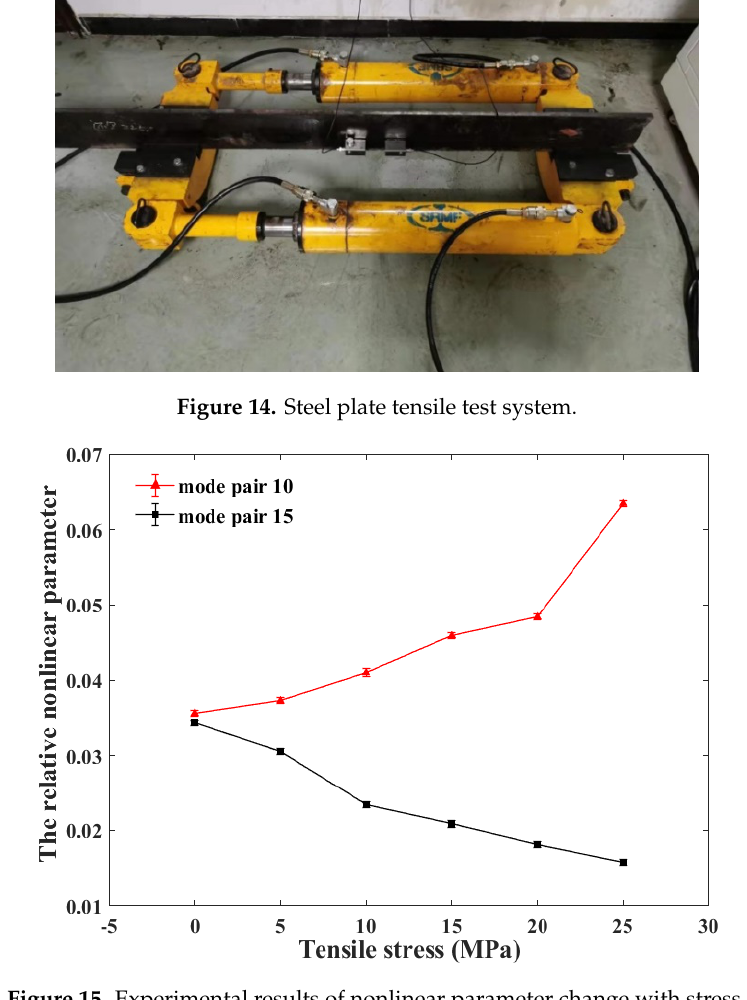
Figure 15. Experimental results of nonlinear parameter change with stress.